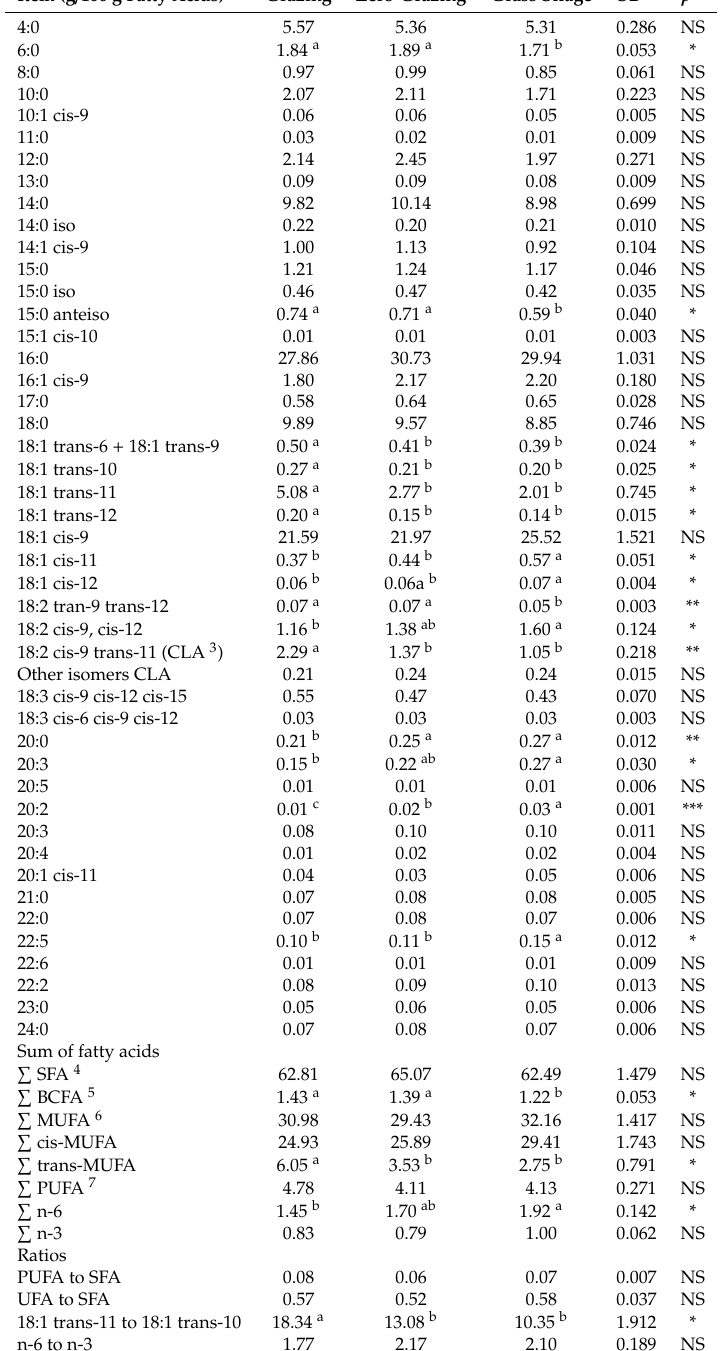
Table 3. Fatty acids profile in milk according to mode of supply of herbage to dairy cows: grazing, zero-grazing or grass